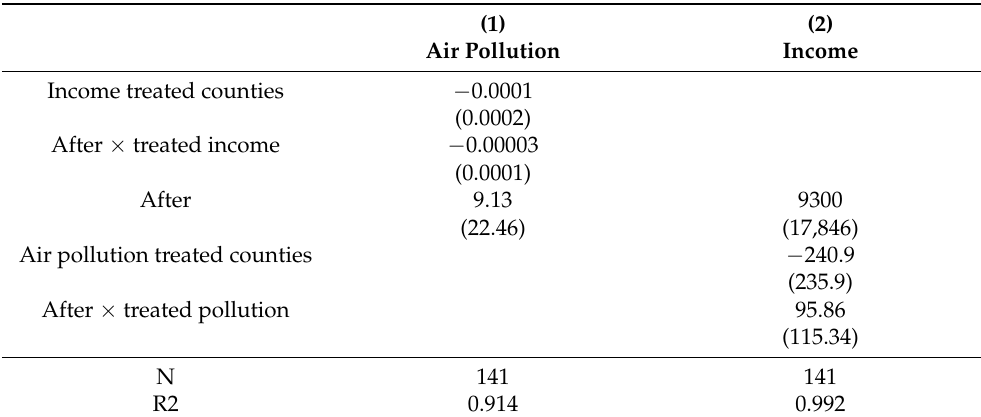
Table 5. Finding the potential interactions of the mechanisms on each other to isolate the effect of the fossil fuel energy on the latent variables—death and violent crime rates—through the mechanisms. (1)